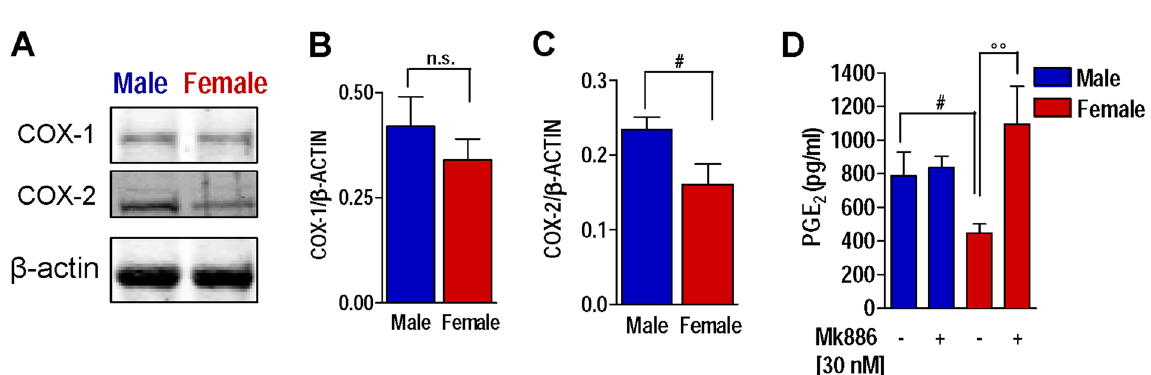
Figure 5. Capacity of human neutrophils for PGE 2 production is sex-dependent. PGE 2 production in human neutrophils from male and female donors after LPS or A23187 stimulation. Neutrophils from male and female donors were incubated with ( A ) LPS (1 µ g/ml) for 0, 0.5, 3 and 20 hrs, or ( B ) with 0.5 µ M A23187 for 0, 5, 15, 30, 60, 120, and 240 min. The reactions were stopped on ice, and PGE 2 levels were measured by ELISA. ( C ) After selected time points (0, 5, 15, 30, 60, 120 min) upon stimulation with A23187 (0.5 µ M), free 3 H-AA content in the supernatant of 3 H-AA-pre-labelled neutrophils was evaluated by scintillation counting. Values represents means ± S.E.M of n = 3 – 6 experiments each in duplicate. # p < 0.05, ## p < 0.01, male vs female cells; two-way ANOVA plus Bonferroni.